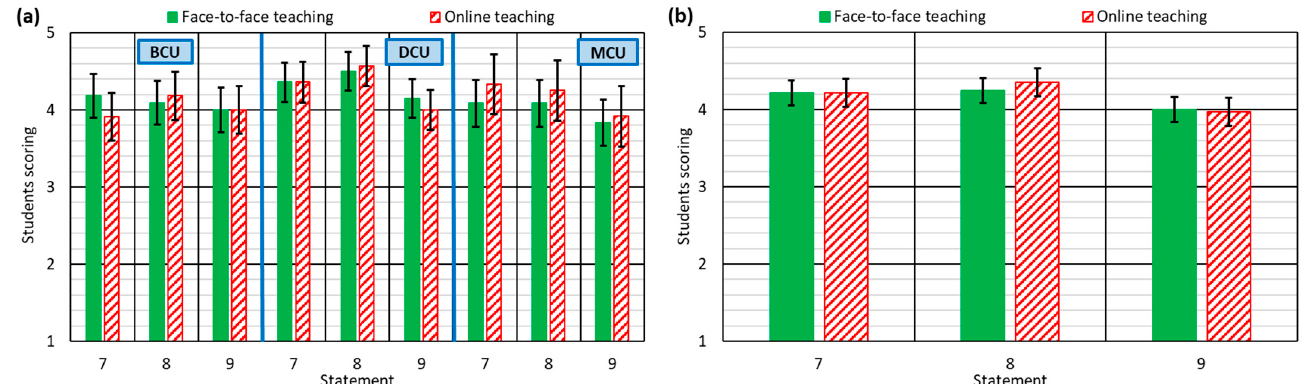
Figure 3. Student responses to statements 7–9: ( a ) for each type of course unit; ( b ) for all course units.